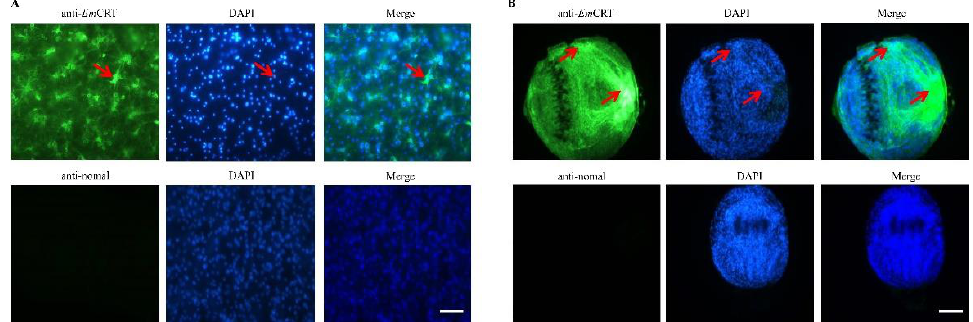
Figure 4. Immunolocalization of Em CRT in E. multilocularis metacestode larvae. Metacestode vesi- cles ( A ) and PSCs ( B ) were incubated with anti- Em CRT mouse serum and normal mouse serum, respectively, then probed with Alexa 488-conjugated anti-mouse IgG. The nuclei were stained with 4’, 6 -diamidino-2-phenylindole (DAPI, blue). Scale bar = 100 μm. The arrows indicate the area with highly expressed Em CRT.